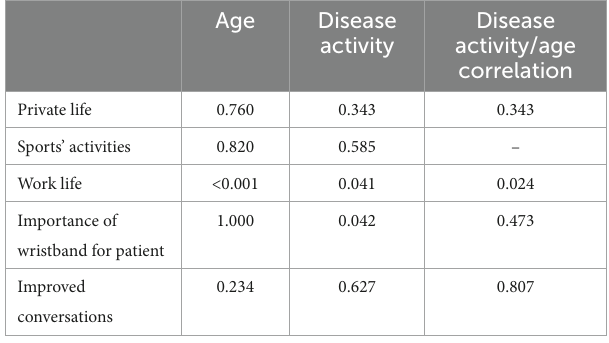
TABLE 6 Results of rANOVA-analysis of multiple independent